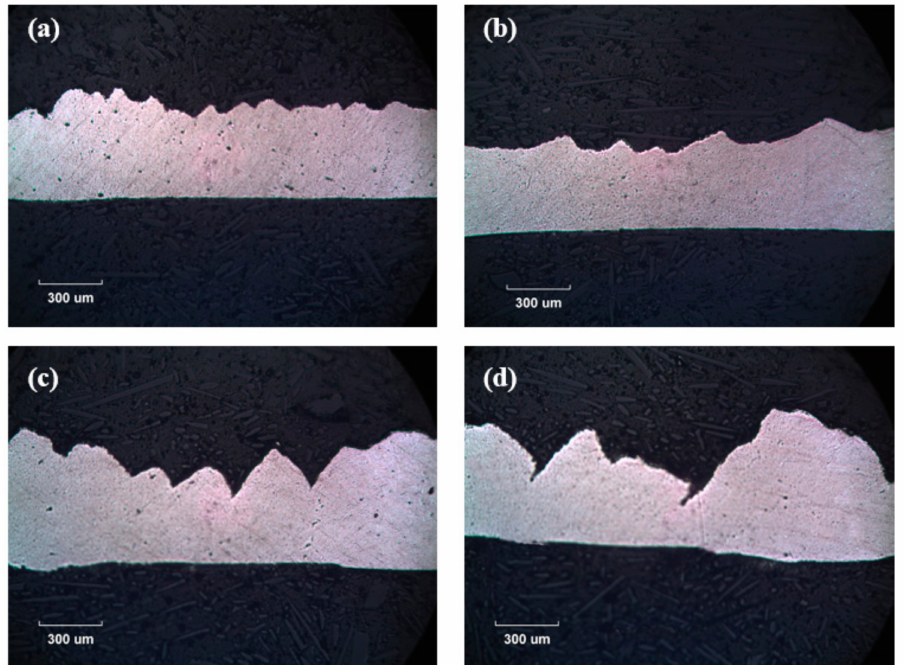
Figure 9. Photomicrographs of chips formed at ( a ) v = 1750 m/min, f = 0.4, d = 4 mm; ( b ) v = 2000 m/min, f = 0.4, d = 3 mm; ( c ) v = 2250 m/min, f = 0.4, d = 2 mm; ( d ) v = 2500 m/min, f = 0.4, d = 1